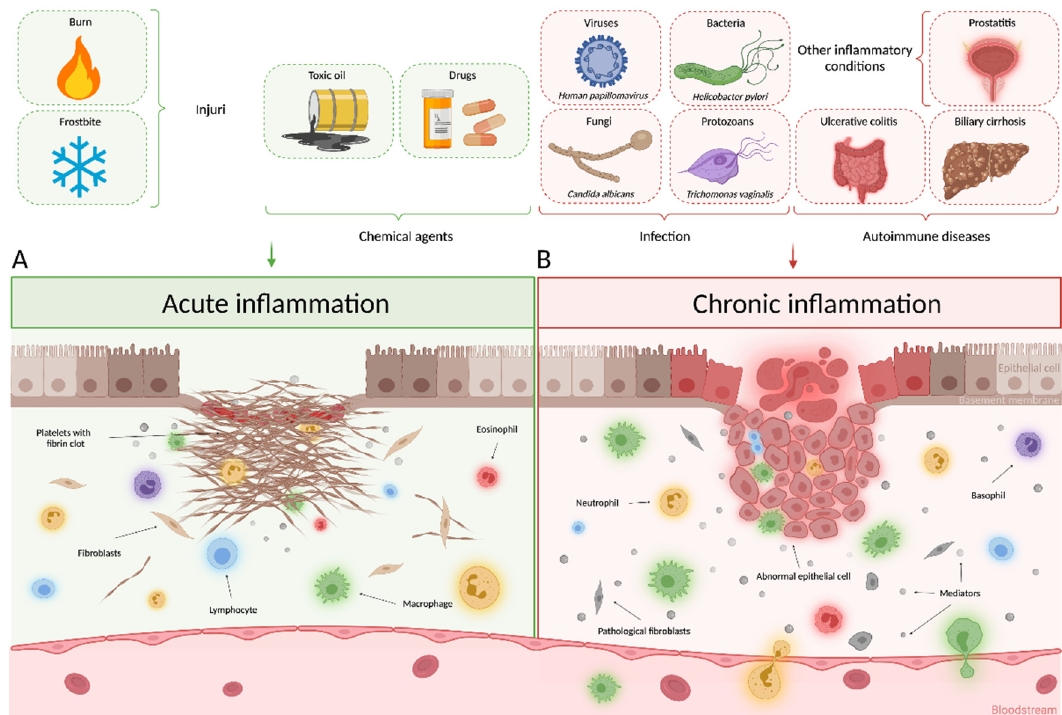
Figure 7. Comparison of wound healing in acute inflammation and the neoplasm development in chronic inflammation. ( A ) Acute inflammation is caused by stress, such as tissue damage or surgery, as well as by the action of various chemical agents. Normally, when tissues are damaged, platelets are activated, which forms a hemostatic plug and releases mediators that regulate vascular permeability and the formation of a fibrin clot; the venous network is restored, and repeated epithelialization occurs throughout the wound, which promotes healing and termination of the complex process of interaction of immune, stromal, and epithelial cells. An untimely stop of acute inflammation leads to its transition to a chronic form. ( B ) Chronic inflammation can occur for various reasons (continuous contact with infection, autoimmune diseases, and other inflammatory conditions) and can be a trigger for the formation and progression of cancer diseases. Hyperactivated cells of the immune system (macrophages, neutrophils, lymphocytes, basophils, and eosinophils) secrete a variety of inflammatory mediators (cytokines and chemokines). In turn, these systemic increases of mediators are a trigger for the transformation of normal cells into abnormal cells, which enhance tumor growth in malignant neoplasms, stimulate angiogenesis, and induce migration and maturation of pathological fibroblasts, which contribute to the spread of metastases.